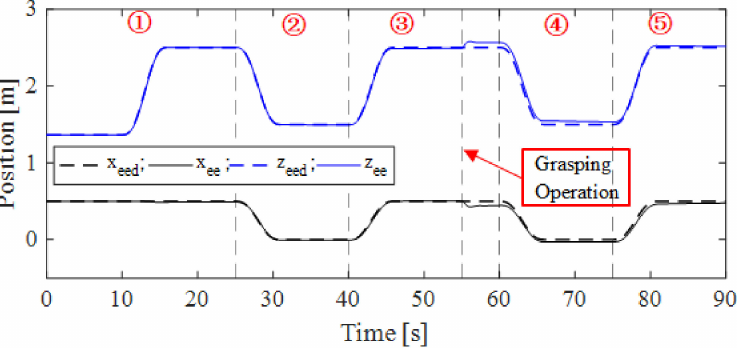
Figure 12. The desired and actual position of end effector with vehicle position and attitude control.